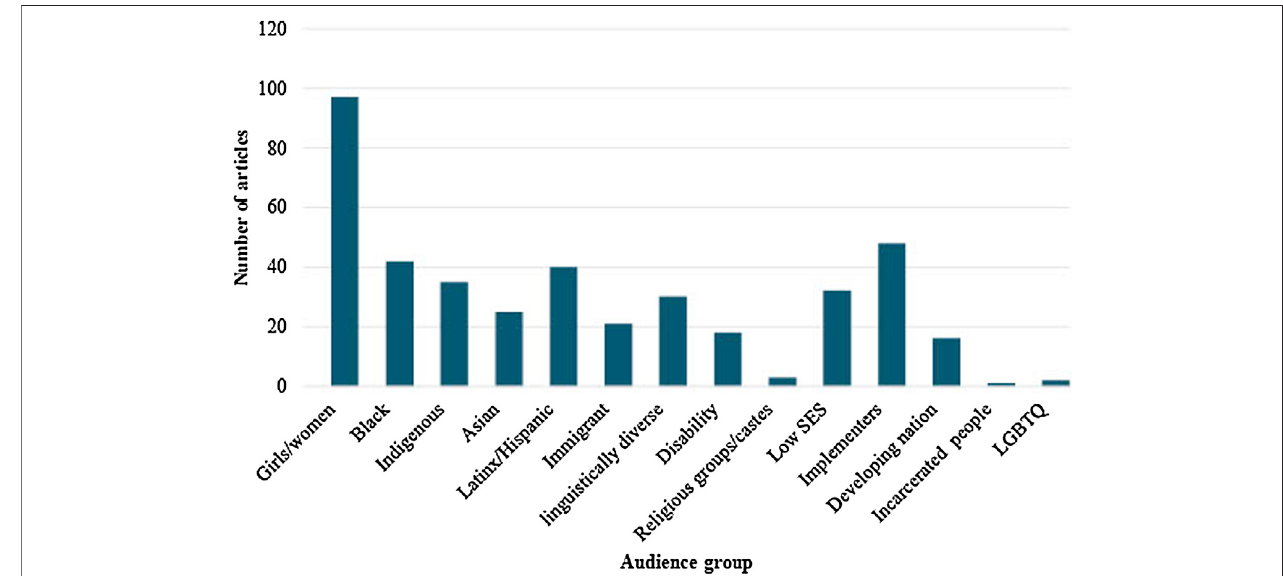
FIGURE 4 | Comparison of audience groups focused on in articles ( n (cid:1) 213). Articles could have more than one audience focus.